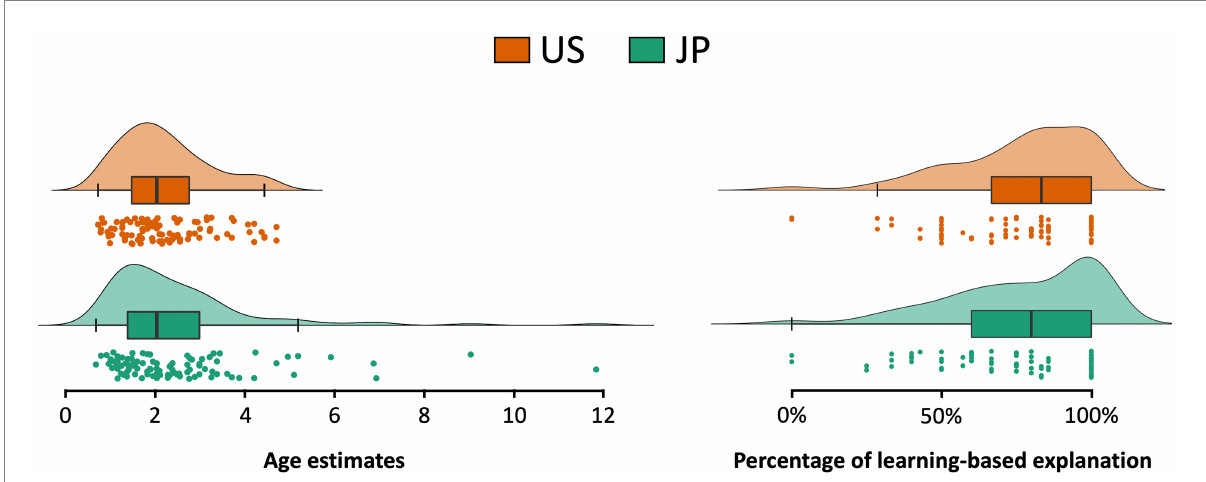
FIGURE 2 Raw data of participants’ estimated age onset for core ability emergence was presented as raincloud plots (jittered raw data, box plots, and split violin plots). Left and right plots depict data of age estimates of core ability emergence and the percentage participants used learning-based explanation on core ability emergence,